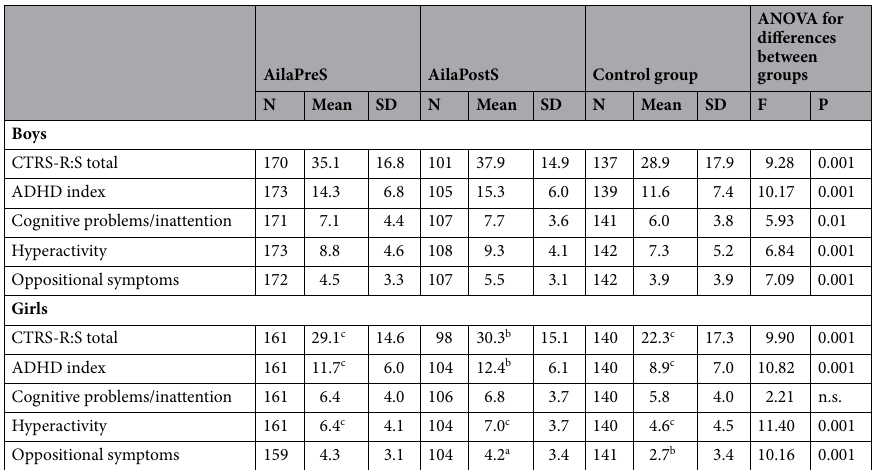
Table 2. Descriptive statistics of the CTRS-R:S indices in the AilaPreS, AilaPostS and control group. Differences were assessed by one-way ANOVA, and sex differences were assessed by the t-Student test for independent samples (marked at only significant p – level). AilaPreS prenatally Aila-exposed children, AilaPostS postnatally Aila-exposed children, Control non-exposed to Aila counterparts, F F-statistic from ANOVA test, p the level of significance of result, a, b and c—intragroup statistically significant differences between girls and boys: a p < 0.05, b p < 0.01, c p <